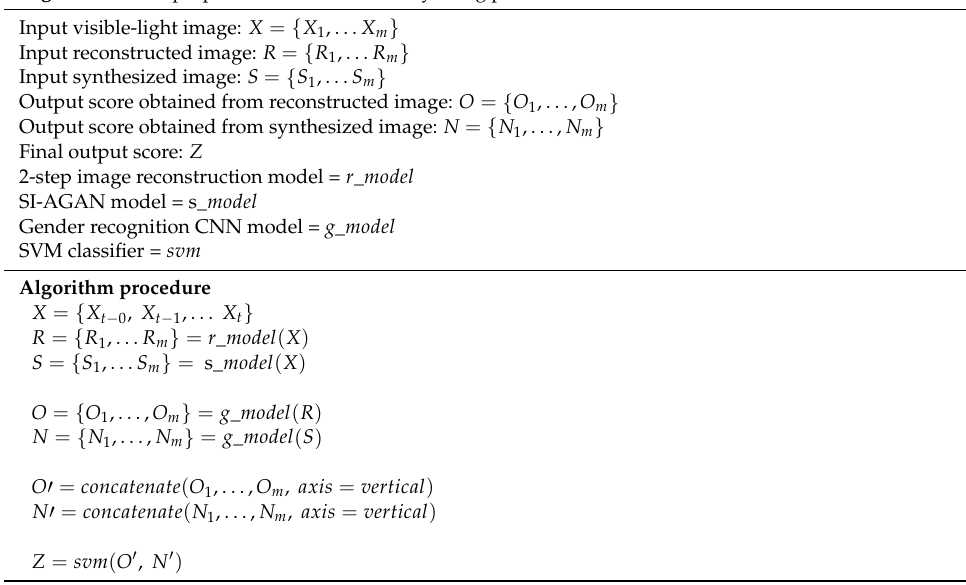
Figure 1. Flowchart of the proposed method. Algorithm 1 The proposed method detailed by using pseudo